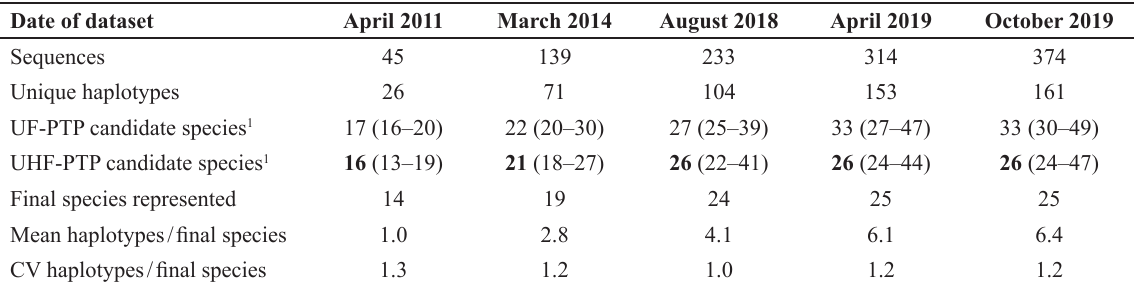
Table 4. Numbers of candidate species from Poisson-tree-process (PTP) analyses (with or without unique haplotype filtering, UHF/UF) of COI barcodes as sampling progressed. All analyses were re- run retrospectively with the same outgroup and model settings. PTP analyses using highest Bayesian support values to fit the models (95% confidence intervals from PTP analyses in parentheses).